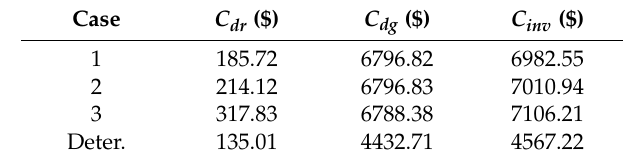
Table 5. Investment cost for a co-planning scheme in different cases.